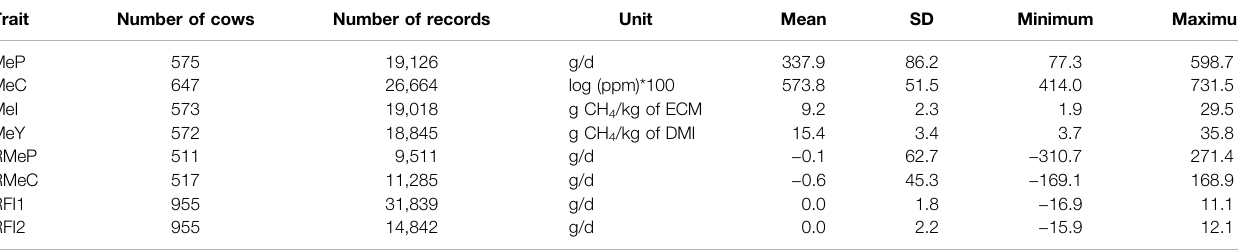
TABLE 1 | Descriptive statistics for methane, and ef fi ciency traits for Danish Holstein cows. Trait Number of cows Number of records Unit Mean Minimum Maximum